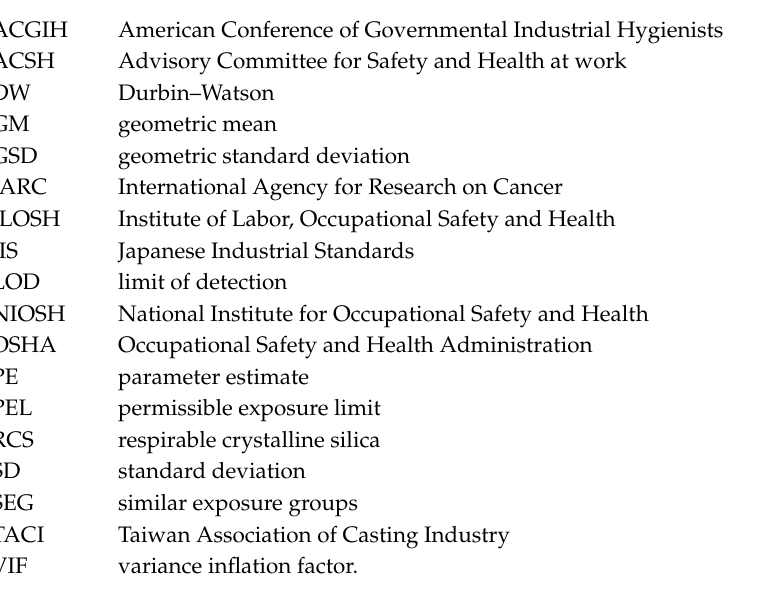
Figure S1: Residual diagnostics of the predictive regression model for base-10 logarithmically translated levels of respirable dust, Figure S2: Residual diagnostics of the predictive regression model for base-10 logarithmically translated levels of respirable crystalline